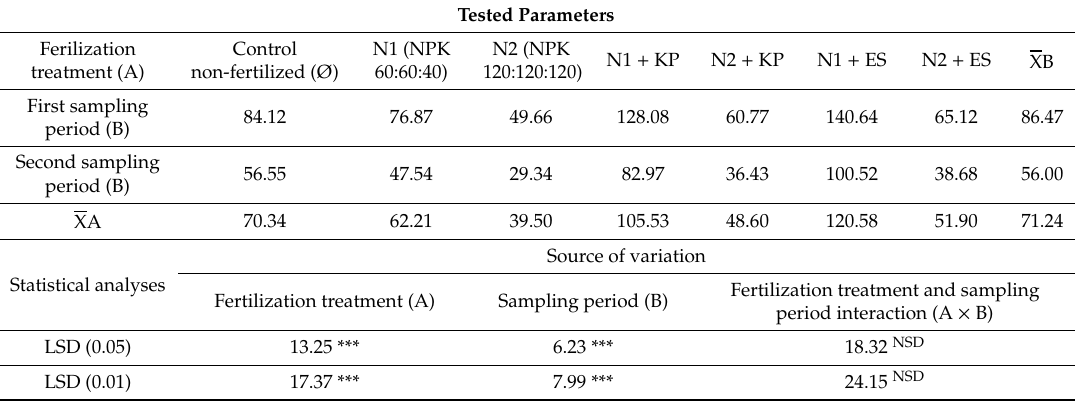
Table 2. E ff ect of the fertilization treatment (A), sampling period (B), and fertilization treatment